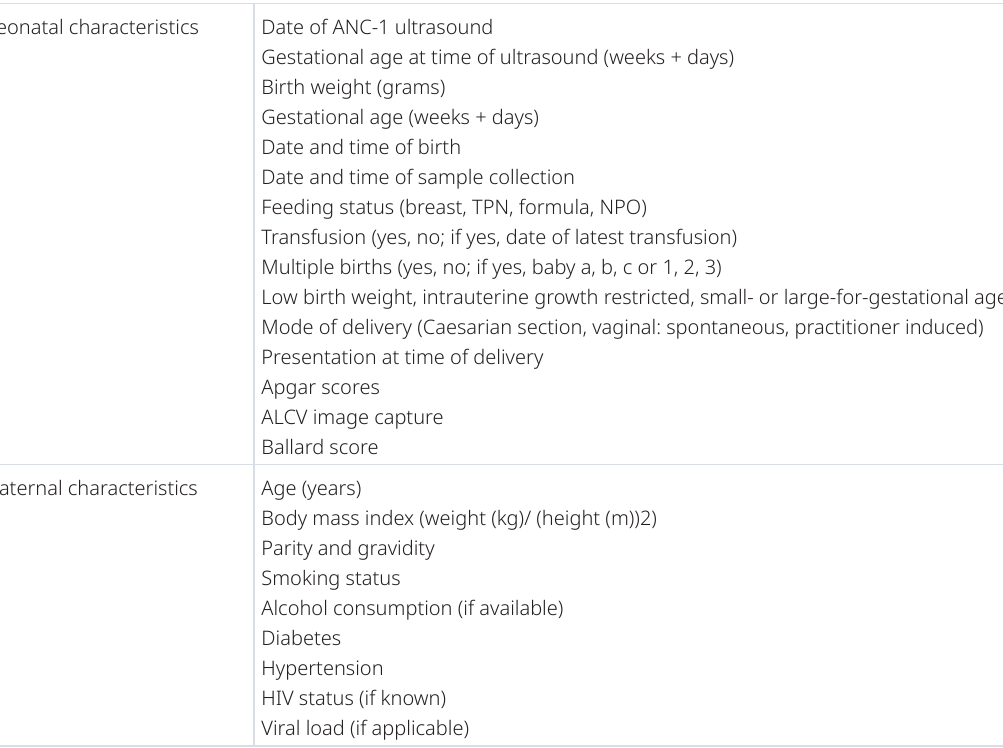
Table 3. Maternal and neonatal covariates to be included for the study. Neonatal